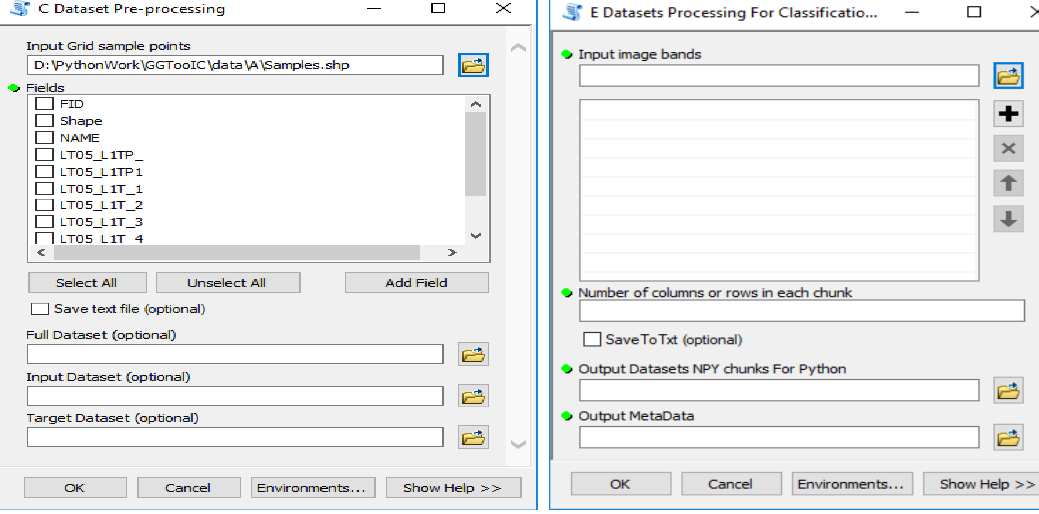
Figure 3 C Tool Parameterization (Dataset Pre-processing) E (Datasets Processing For Classification based on chunks)